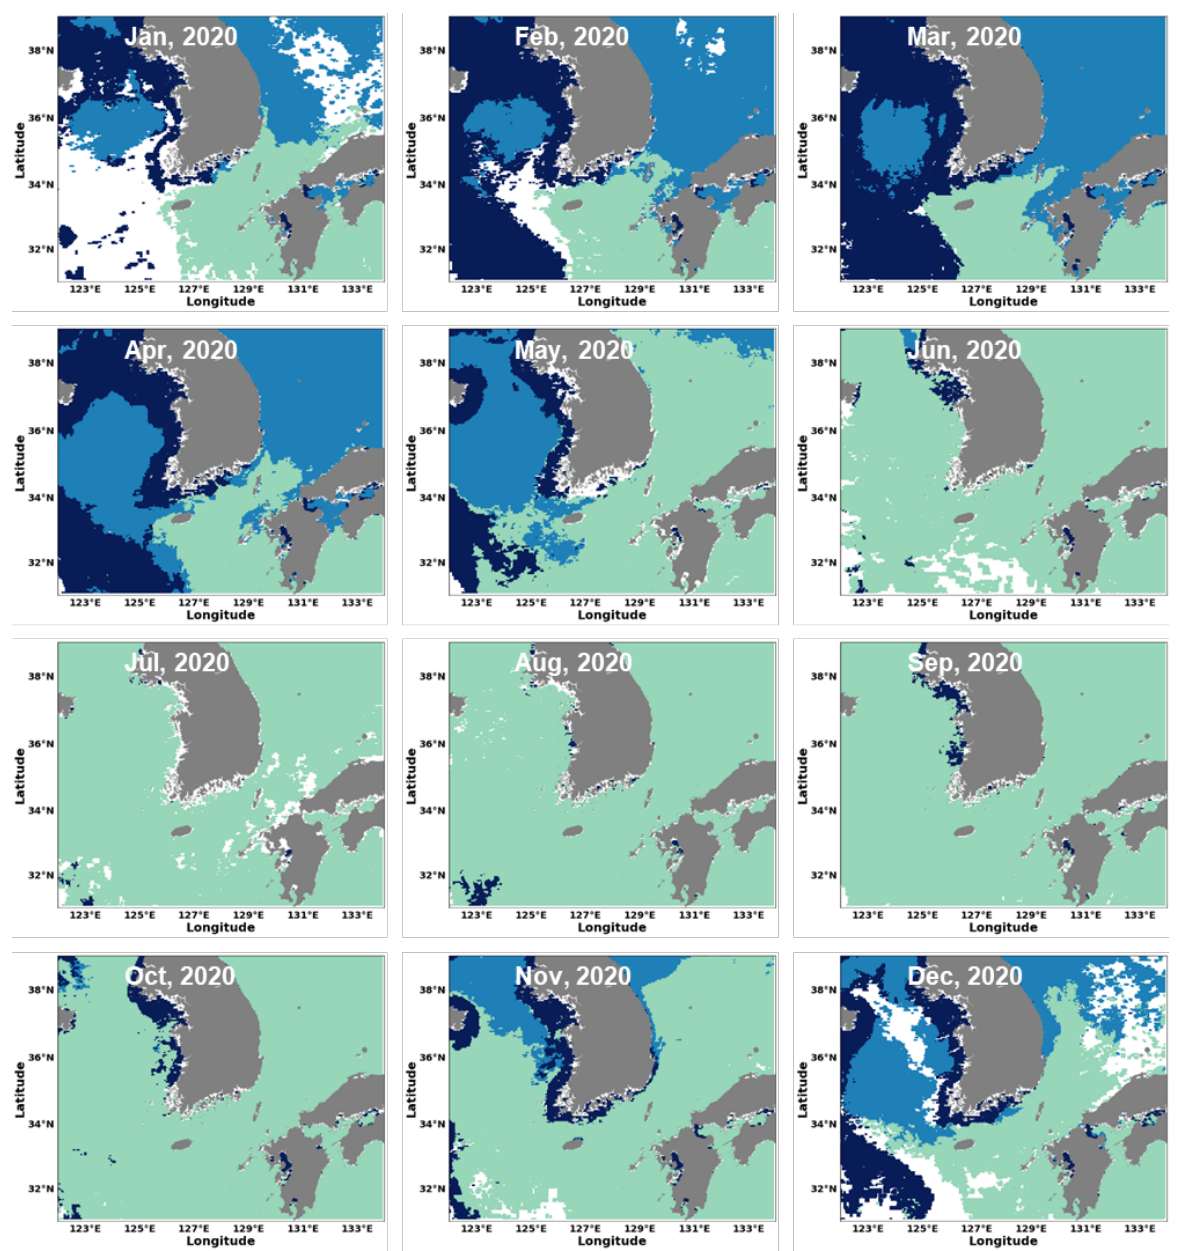
Figure 5. Classification based monthly PSCs distribution using L3 mapped VIIRS data in 2020. White color indicates a missing area by the cloud. Indigo, blue, and green colors indicate micro-size phytoplankton, nano-size phytoplankton, and pico-size phytoplankton, Table 4. Matched percent between field measurement Chl-a size fractionated with New AI algo- rithm (this study), A ph algorithm, and three-component model derived from satellite data.